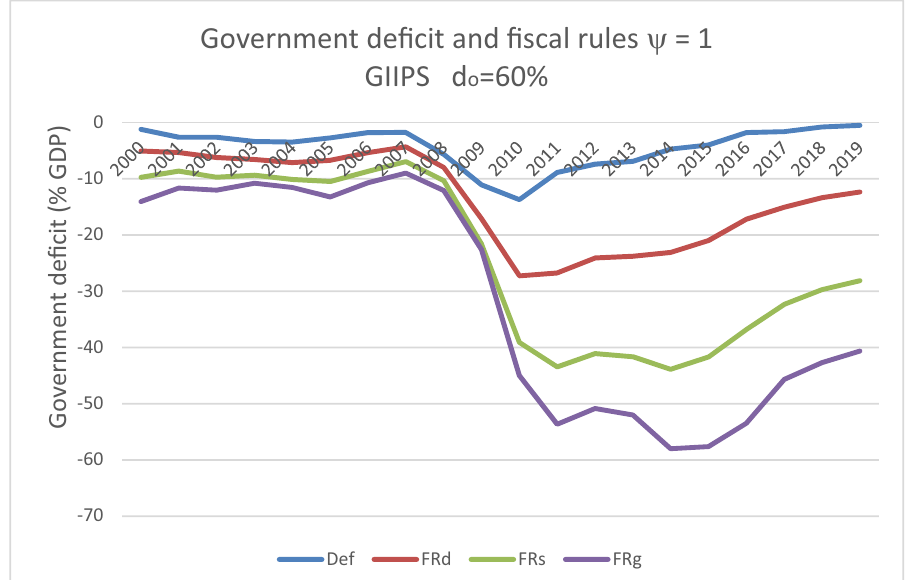
Figure 1.4: GIIPS countries government de fi cit ψ = 1 ( Source: Own elaboration from data on Table 1 )